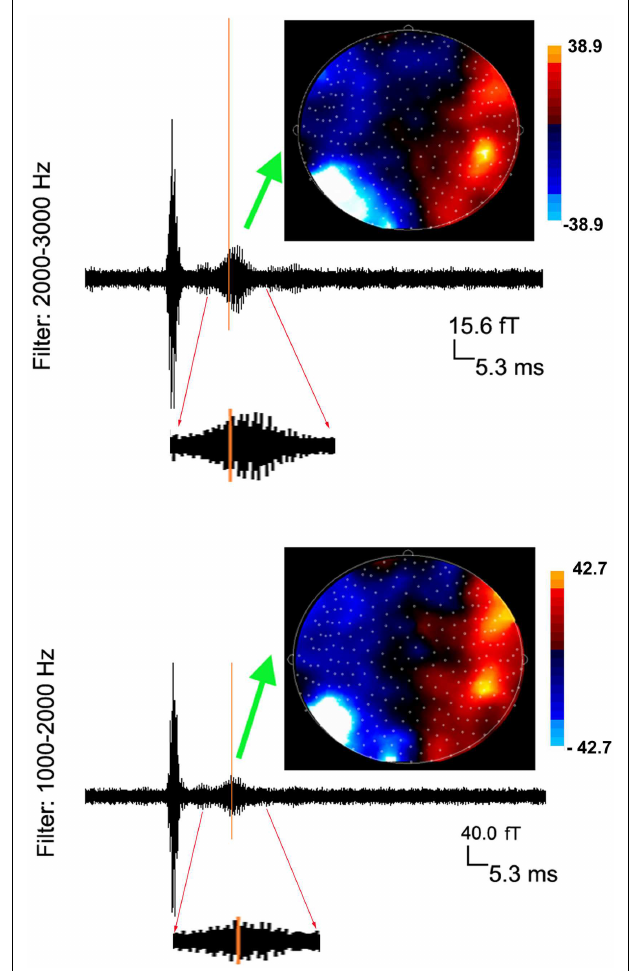
FIGURE 2 |Averaged waveforms and contour maps from one subject showing neuromagnetic activation in 1000–3000Hz evoked by left finger stimulation .The latency of neuromagnetic activation does not change with the increase of frequency range. However, the amplitude of neuromagnetic activation significantly decreases with the increase of frequency range (see the scales).Waveforms from 10 to 30ms are “zoomed in” to show the detailed deflections (oscillations) elicited by finger